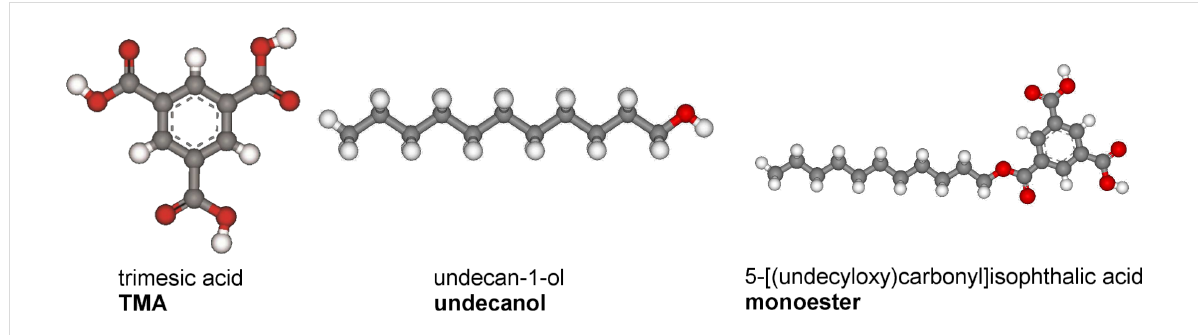
Figure 1: Molecular structures of the molecules involved in the study and shortened forms of their names (in bold).